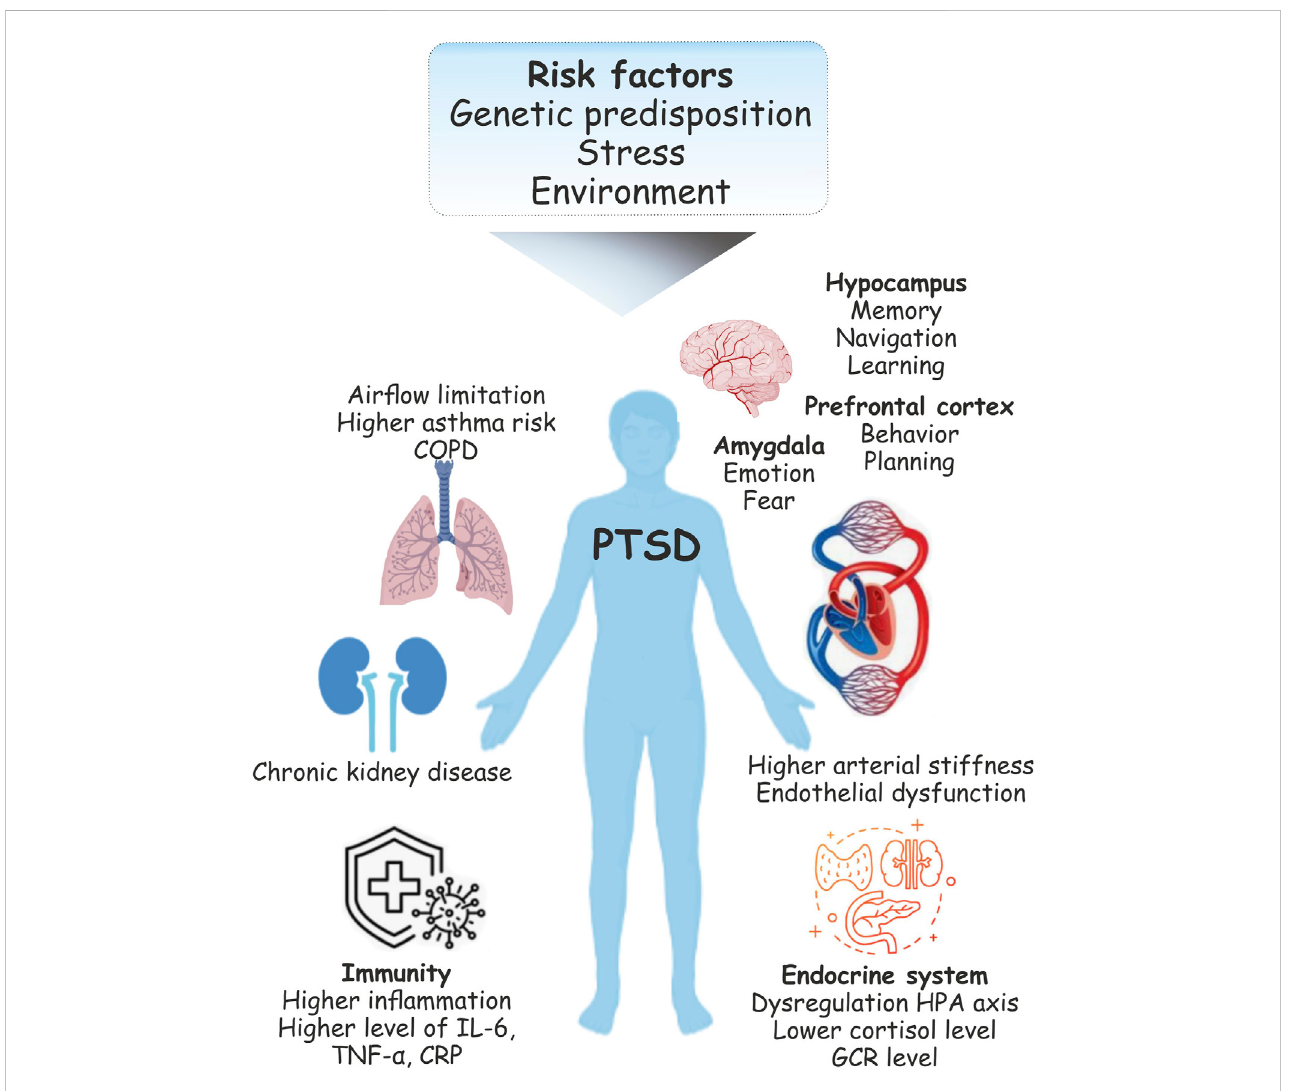
FIGURE 1 Physiological changes during post-traumatic stress disorder (PTSD). Following the traumatic event, PTSD is common and is one of the serious health concerns.PTSDcanbeassociatedwithlastingchangesinthebrainareasimplicatedinthestressresponseincludetheamygdala,hippocampus,andprefrontal cortex. Functional limitations and respiratory syndromes may co-ocuure with PTSD. Stress is also the major risk factor for cardiovascular disease (CVD). Pathophysiologyincludes changesintheimmunesystemfunctioninindividualswith PTSDsuggestitsassociationwithenhancedimmune in fl ammatory